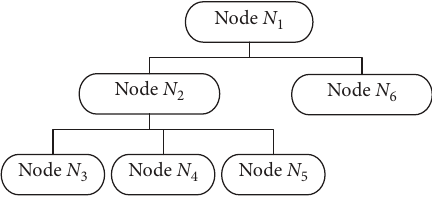
Figure 4: Structural importance example.